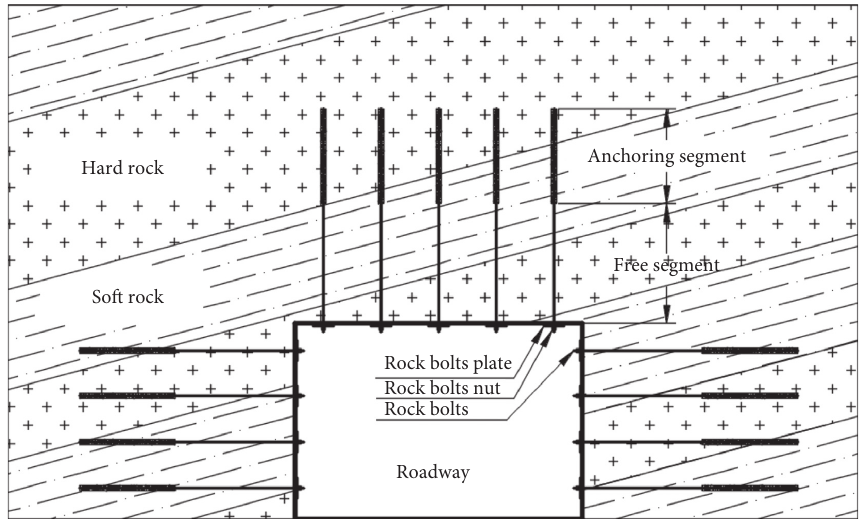
Figure 2: Schematic diagram of roadway support in the slanted soft and hard composite rock strata.